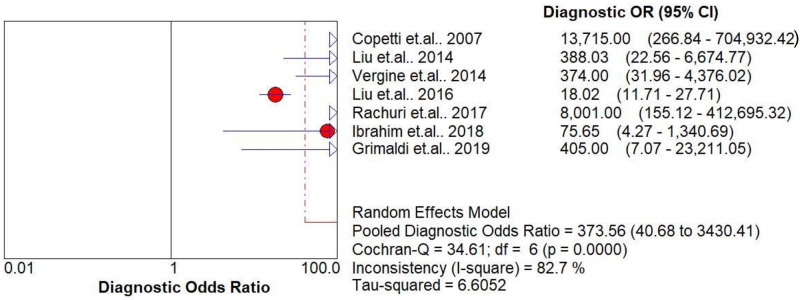
Summary of diagnostic odd’s ratios of the double-lung point for transient tachypnea of the neonate.